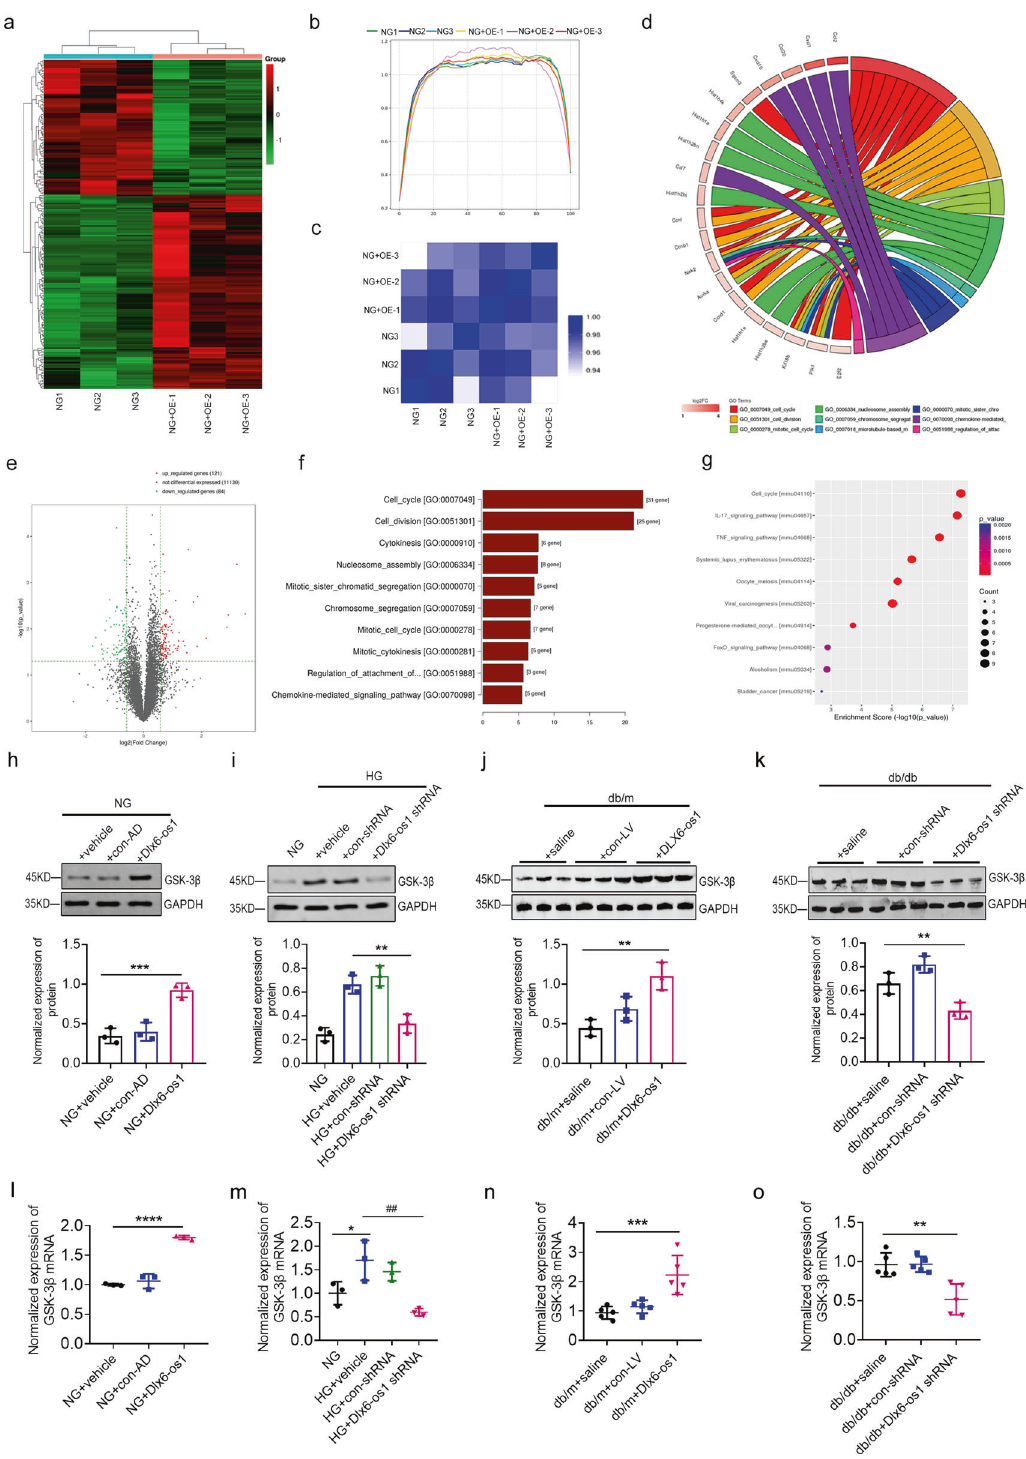
Fig. 7 RNA-seq results after lncRNA Dlx6-os1 overexpression in the cultured podocytes. a The RNA-seq and cluster analysis. NG, normal cultured podocytes; NG + OE, lncRNA Dlx6-os1-overexpressing podocytes. b Transcription coverage map. c A correlation coef fi cient heat map of samples. The shade of blue represents the degree of correlation. d The circle map of differential expression mRNA. e A differential expression mRNA volcano plot. f The BP-enrichment score chart. g The pathway analysis obtained for the enrichment score dot plot. The top ten pathways are shown. h – k Western blots of the GSK-3 β protein of both cultured podocytes (MPC5) and isolated glomeruli from db/m and db/db mice under different treatments. Quanti fi cation of the western blot data were shown below. The intensity of the bands was analyzed in ImageJ and normalized to that of GAPDH ( n = 3). ** P < 0.01, *** P < 0.001 (one-way ANOVA plus Dunnett ’ s multiple comparisons test). l – o qRT- PCR analysis of GSK-3 β gene expression in both cultured podocytes (MPC5, n = 3) and primary podocytes isolated from db/m and db/db mice under different treatments ( n = 5). * P < 0.05, ** P < 0.01, *** P < 0.001, **** P < 0.0001; ## P < 0.01 (one-way ANOVA plus Dunnett ’ s multiple comparisons test).